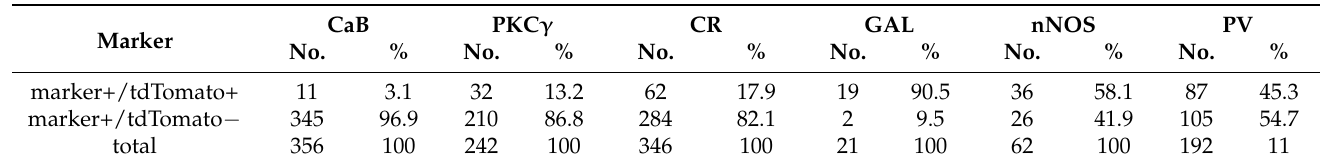
Table 2. Numbers of neurons immunostained for different cellular markers and positive or negative for tdTomato (PAX2) in laminae I–III of the spinal dorsal